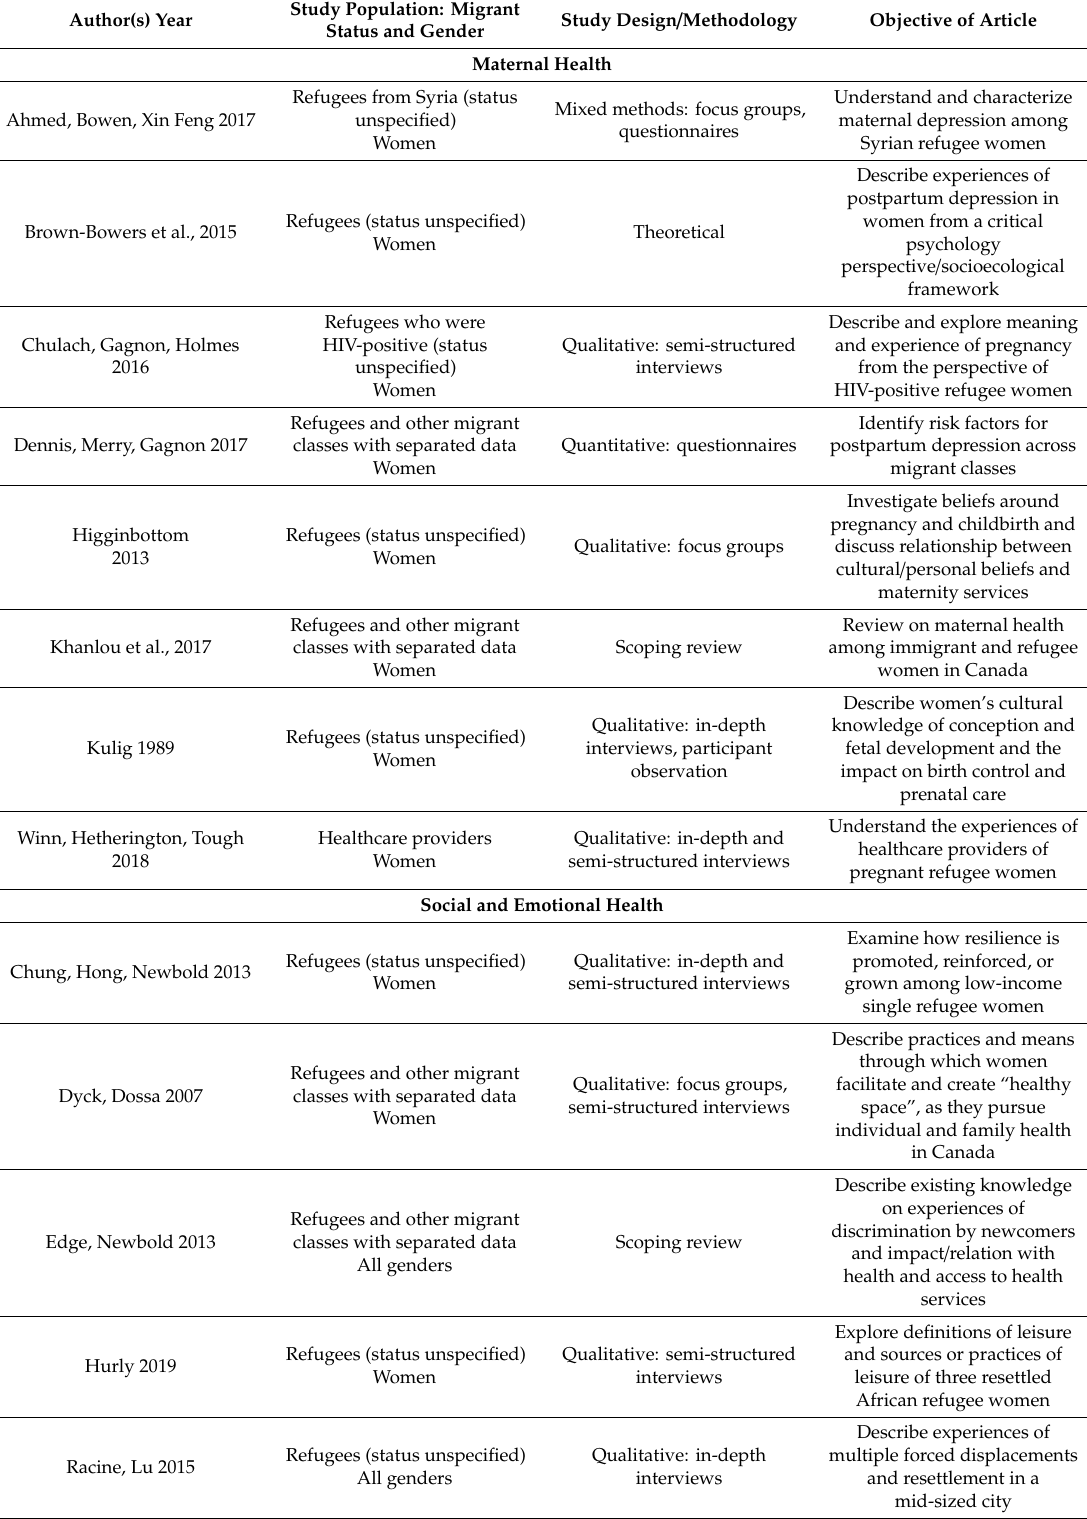
Table 3. Overview of article